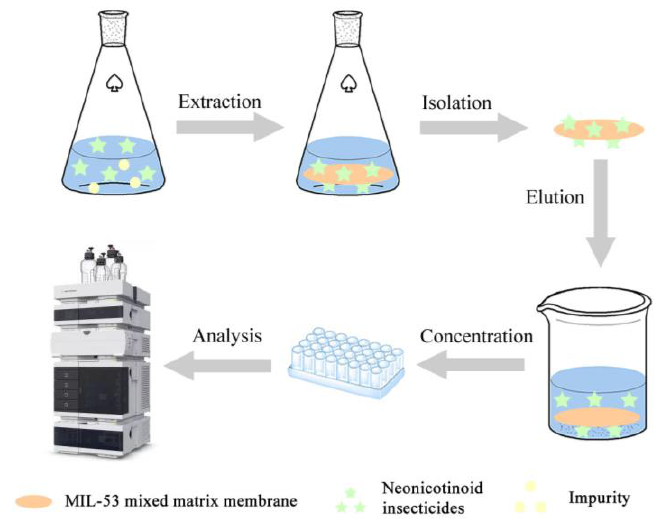
Figure 3. Schematic of the MIL-53 MMM based DME process.